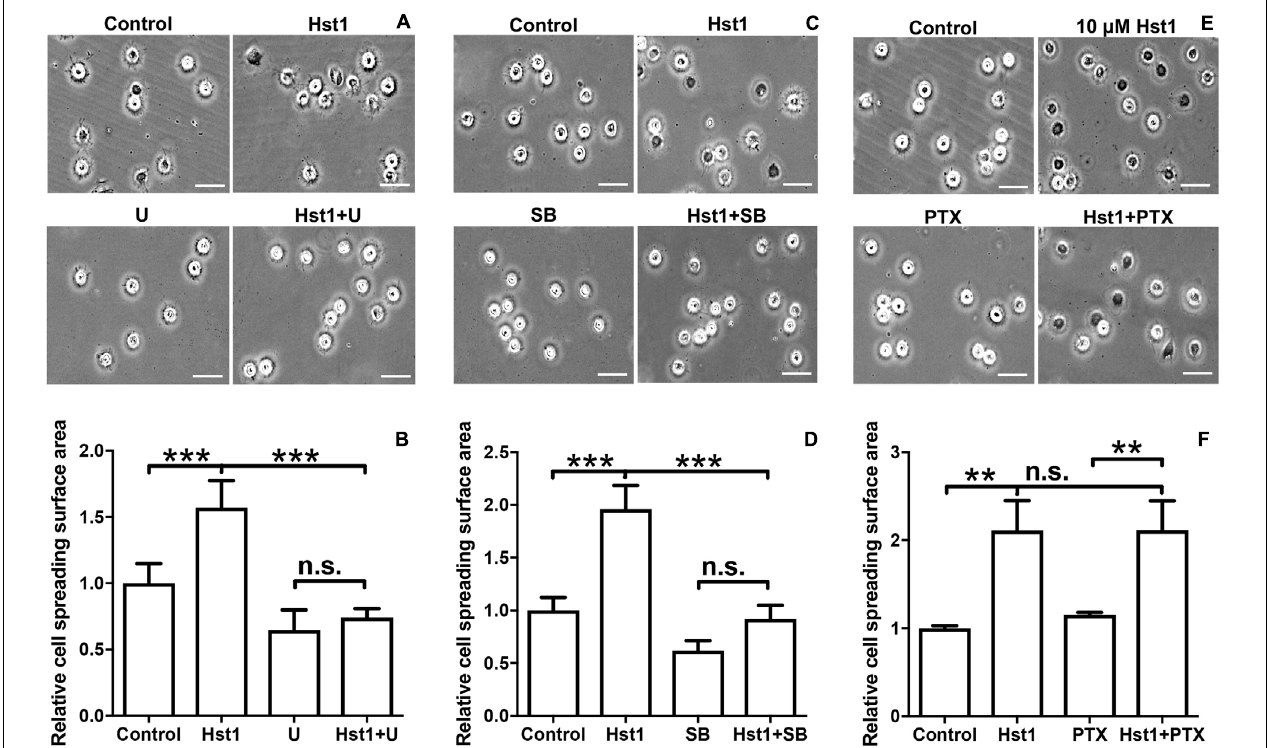
FIGURE 4 | The effects of signaling pathway inhibitors on Hst1-induced spreading of osteogenic cells. Light micrographs depicting the spreading of osteogenic cells that were treated with (A) extracellular-signal-regulated kinase (ERK) signaling (10 µ M U0126), (C) : p38 signaling (10 µ M SB203580) and (E) G protein-coupled receptor (GPCR) (200 ng/mL Pertussis toxin, PTx). Bar = 50 µ m. Relative spreading surface area of osteogenic cells that were treated with Hst1 with or without the pretreatment with the inhibitors of (B) extracellular-signal-regulated kinase (ERK) signaling (10 µ M U0126), (D) p38 signaling (10 µ M SB203580) and (F) G protein-coupled receptor (GPCR) (200 ng/mL Pertussis toxin, PTx). Data are shown as mean ± SD ( n = 6). ** p < 0.01, *** p < 0.001.